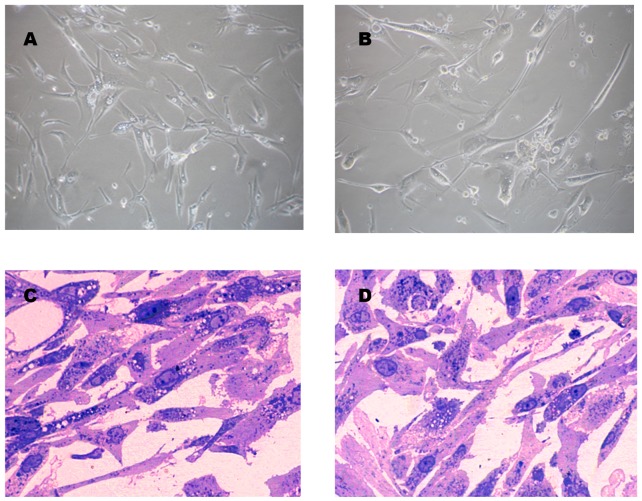
Morphology of in vitro expanded ADSCs.Representative phase-contrast images of in vitro expanded ADSCs from cancer patients (A) and non-tumorigenic participants (donors) (B) at passage 4, and toluidine blue staining of semithin sections of the same cells (C and D, respectively) (magnification 20X).